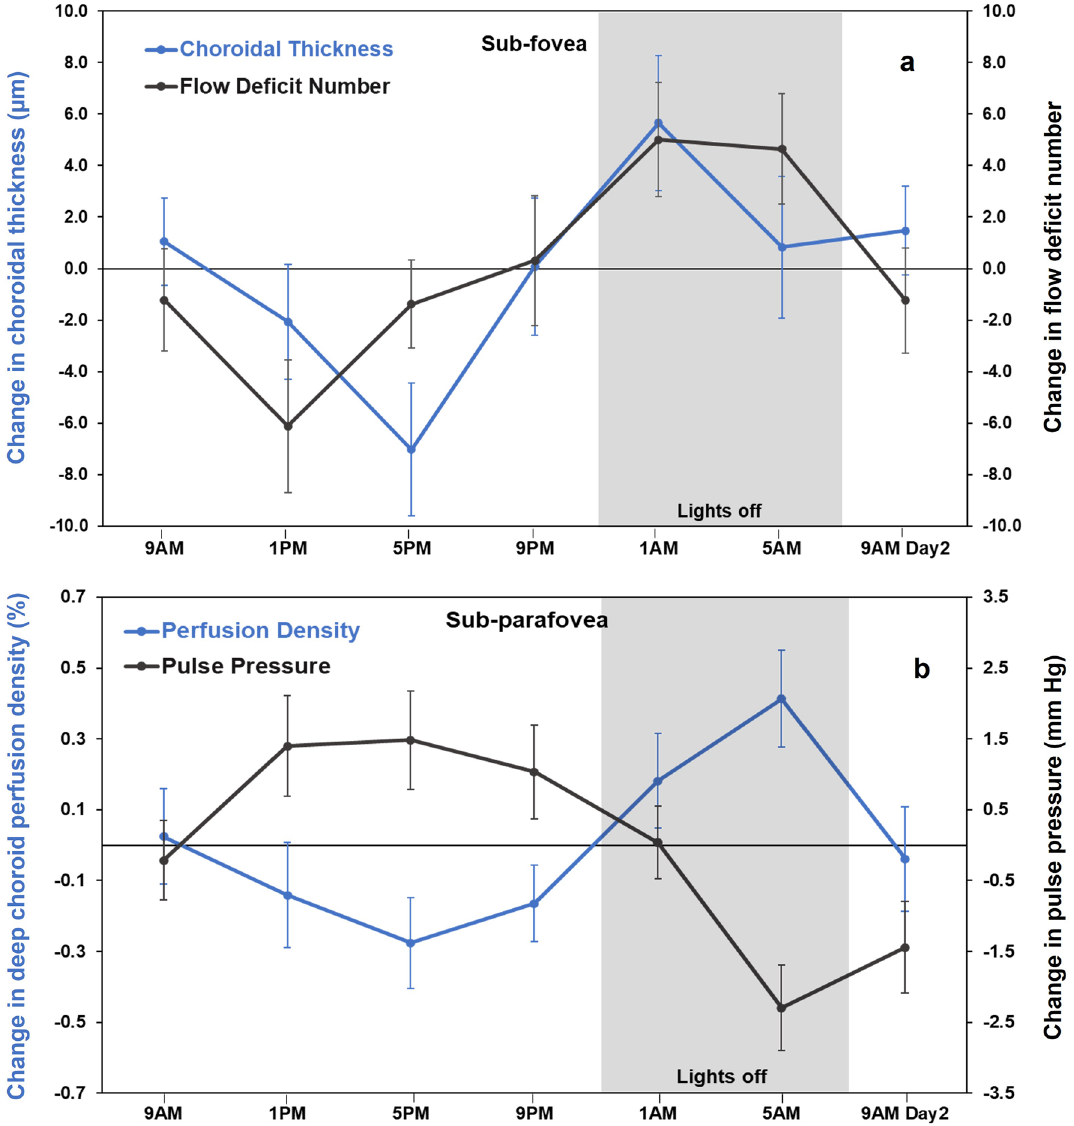
Figure 5. ( a ) Mean change in choroidal thickness (blue) and choriocapillaris flow deficit number (black) in the foveal region across 24 h demonstrating their variations in approximately in phase with each other. ( b ) Mean change in perfusion density of the deep choroid (blue) and pulse pressure (black) in the parafoveal region across 24 h demonstrating their variation in approximately antiphase with each other. For all time points, error bars indicate one standard error of the